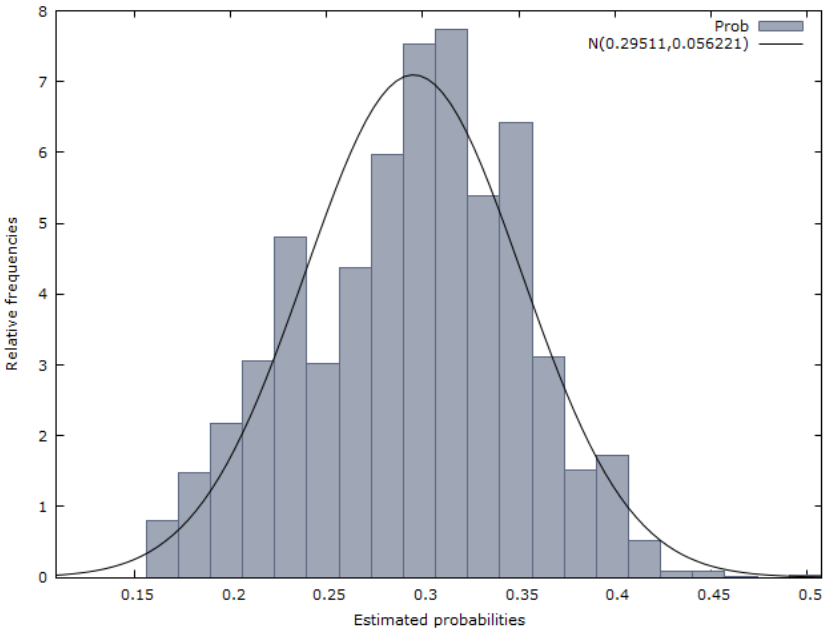
Figure 2. Frequency histogram of the estimated probabilities of visiting the Monfragüe BR. Source: own elaboration using Gretl software.